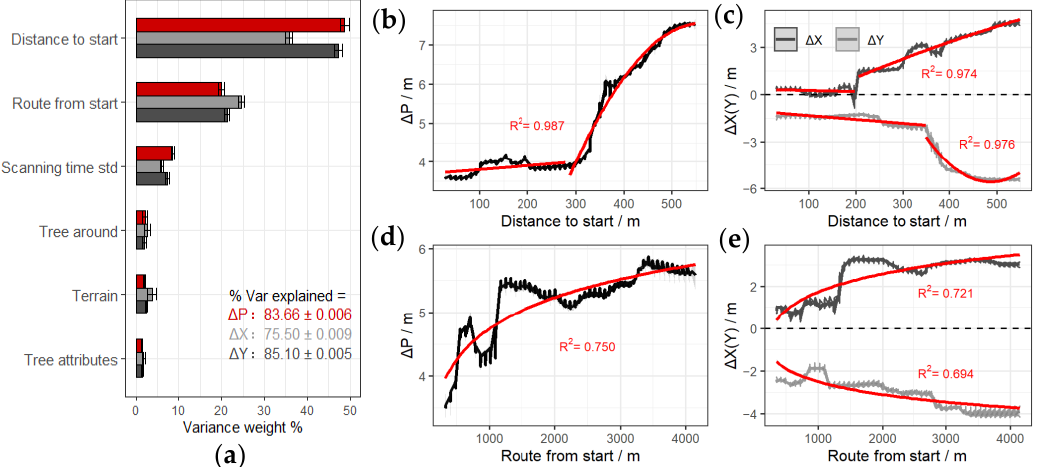
Figure 6. Results of random forest model for ∆ P, ∆ X, and ∆ Y. ( a ) Relative importance of variables. The error lines are the standard deviation of results constructed by randomly drawing 80% of the samples 100 times. Factors with minimal contributions were combined. ( b – e ) Marginal responses of the two most important variables. The black lines are the average marginal response values constructed by